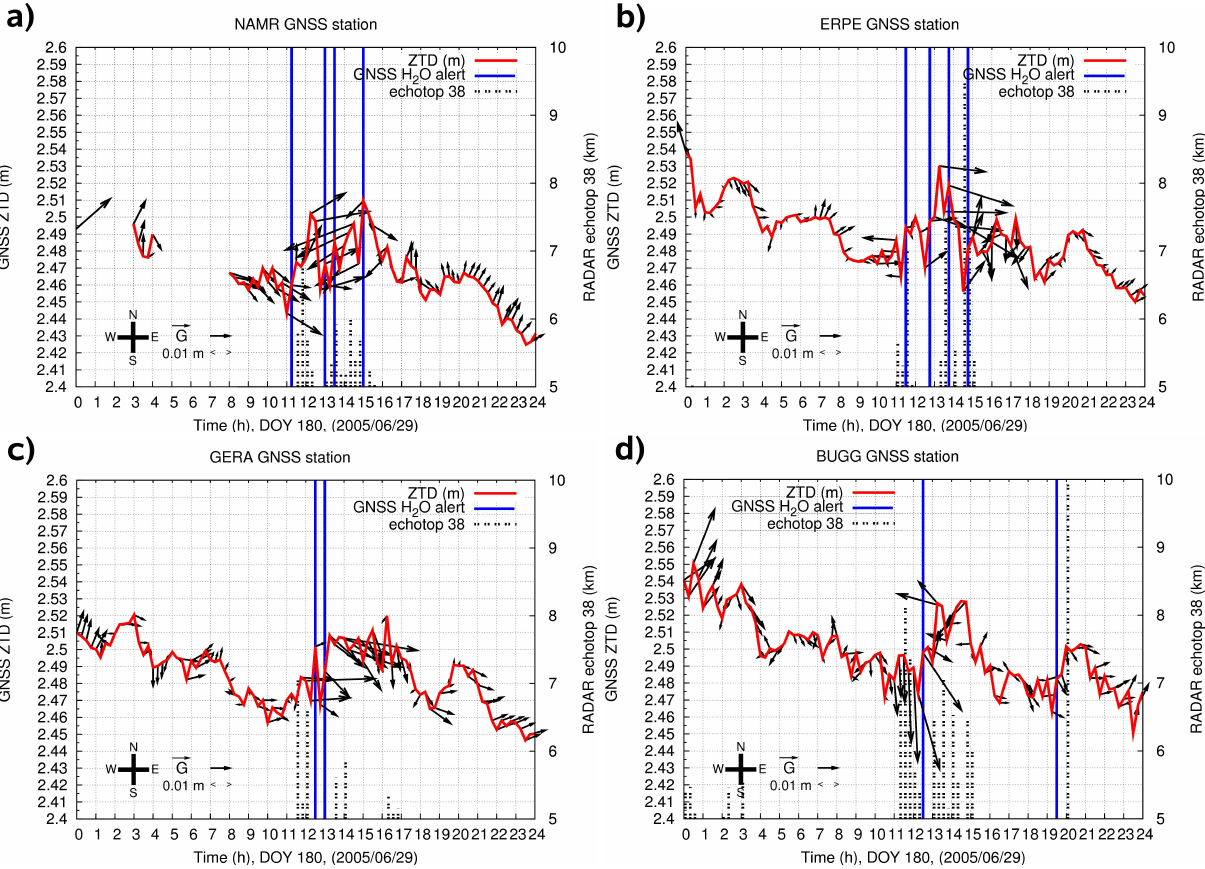
Figure 11. Time series of ZTD and gradients (a) for NAMR, (b) ERPE, (c) GERA, and (d) BUGG stations (29 June 2005). GNSS H 2 O alerts are shown by blue dotted lines. Altitudes of the highest 38dBZ radar echoes are plotted for values over 5km (black dash